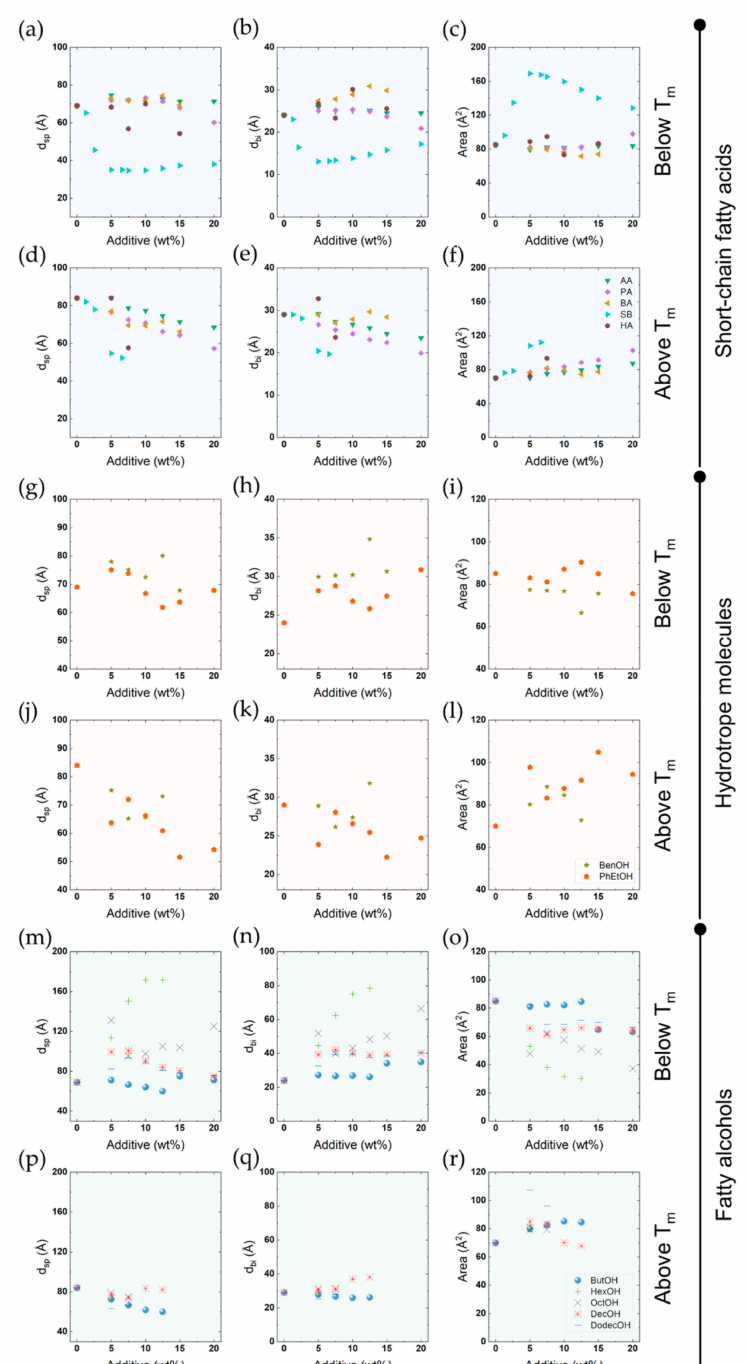
Figure 10. Effects of additives in the interlamellar spacing (d sp ), bilayer thickness (d bi ) and area per surfactant molecule of the DODAC lamellar structure. ( a – f ) Short-chain fatty acids: AA-acetic acid, PA-propionic acid, BA-butyric acid, SB-sodium butyrate, HA-hexanoic acid. ( g – l ) Hydrotrope molecules: BenOH-benzyl alcohol, PhEtOH-phenoxyethanol. ( m –r) Fatty alcohols: ButOH-butanol, HexOH-hexanol, OctOH-octanol, DecOH-decanol, DodecOH-dodecanol. The top panels ( a – c , g – i , m – o ) correspond to the gel phase, and the bottom panels ( d – f , j – l , p – r ) correspond to the liquid crystalline phase. Cubic liquid crystals were identified in systems with hexanoic acid and benzyl alcohol, but the detailed structure was outside the scope of this study. For butanol, we found a similar behaviour as in the case of sodium butyrate. The X-ray